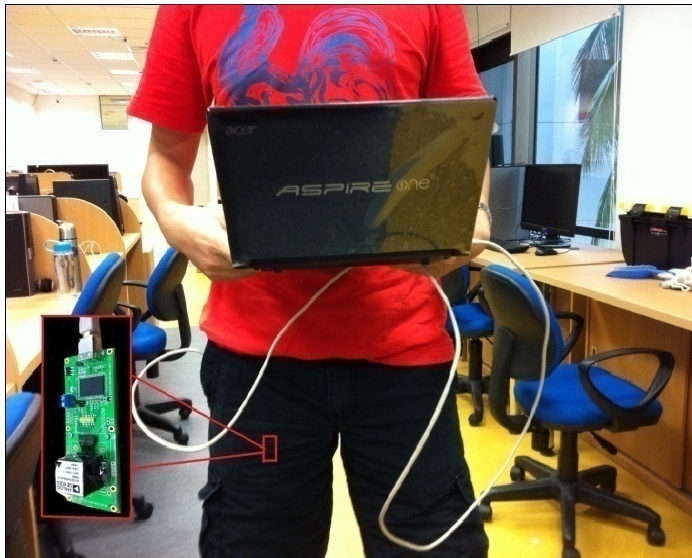
Figure 1. The sensor we used and the setting for data collection.